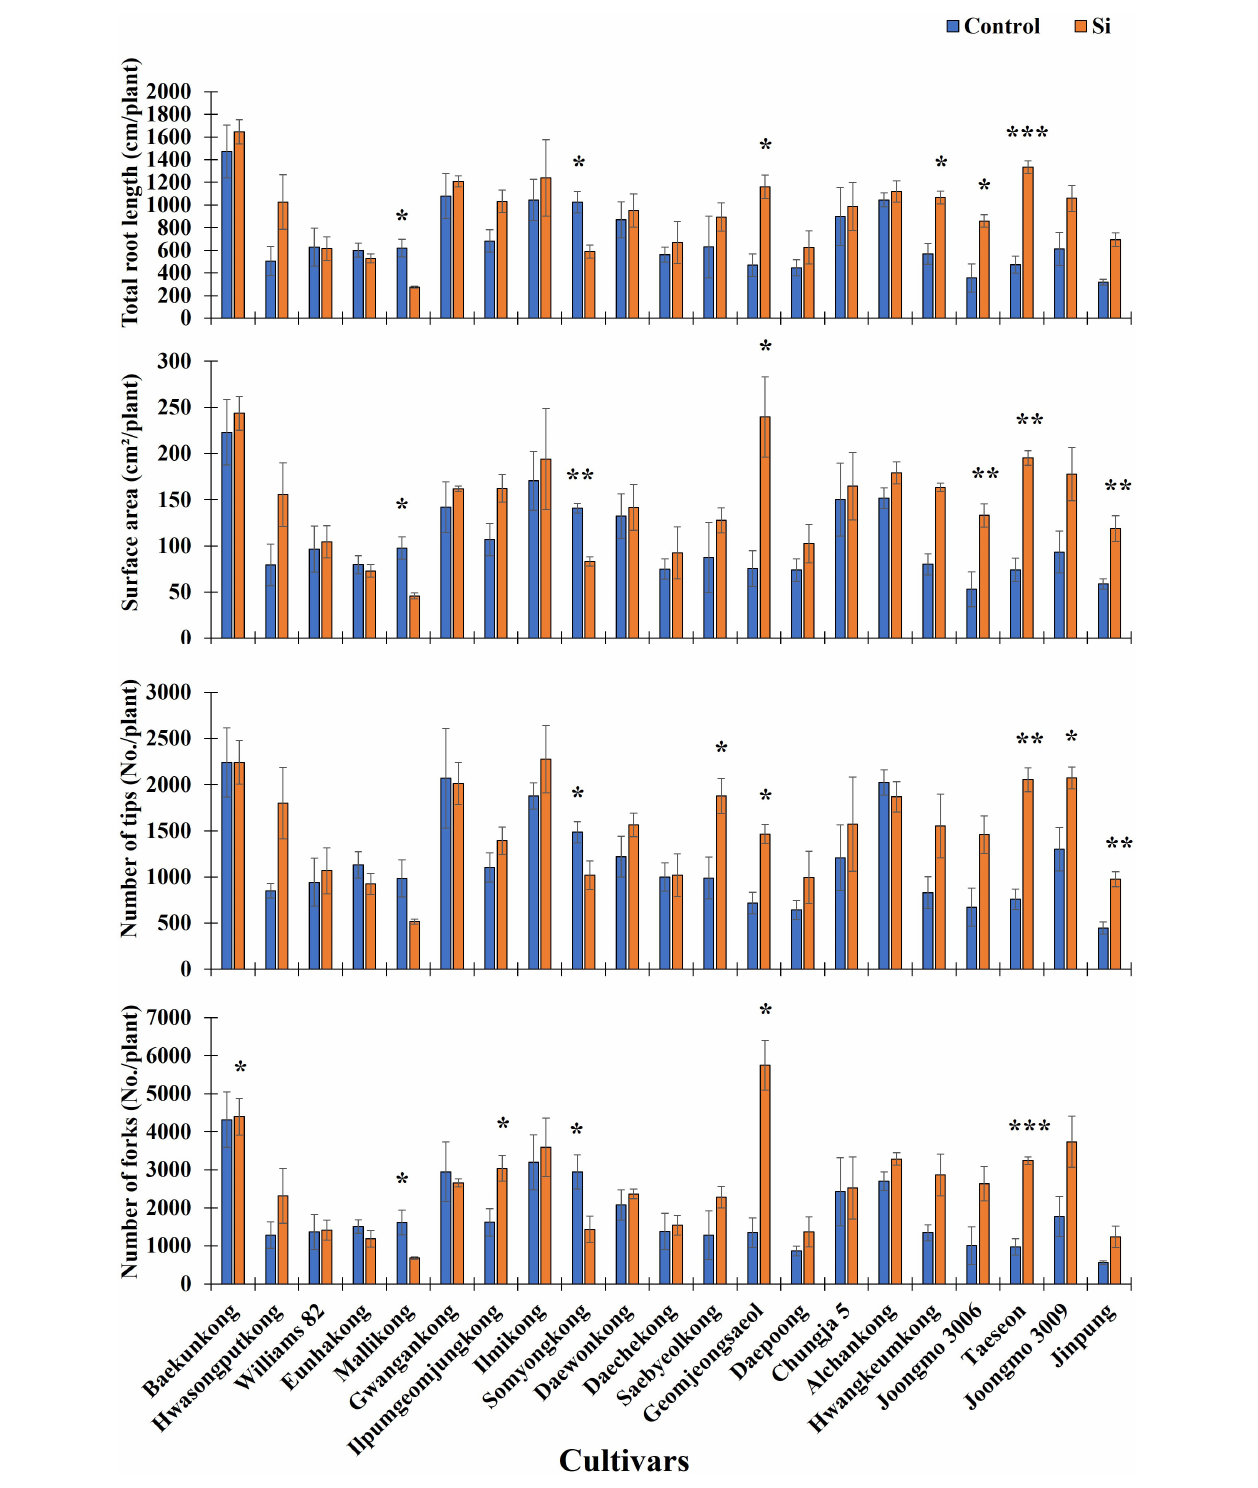
FIGURE 1 | Silicon (Si) effect on total root length (TRL), surface area (SA), number of tips (NTs), and number of forks (NFs) in 21 soybean cultivars. The data were collected 10 days after Si treatment (DAT), and the blue and orange bars represent the control and Si treatment, respectively. In the figure, the vertical bar means average, and error bars indicate standard error. The experiment was conducted by three replications ( n = 3 ). Error bars indicate standard error, and the asterisks indicate significant difference using the Student’s t -test (*0.01 < P < 0.05; **0.001 < P < 0.01; *** P < 0.0001).